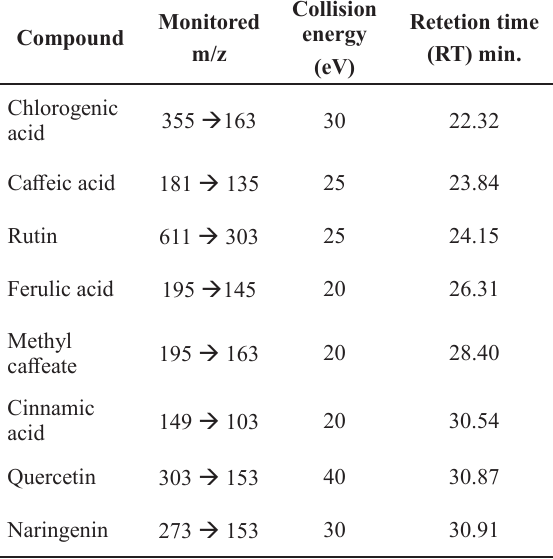
Polyphenols standards with respective fragmentation pattern, collision energy and retention